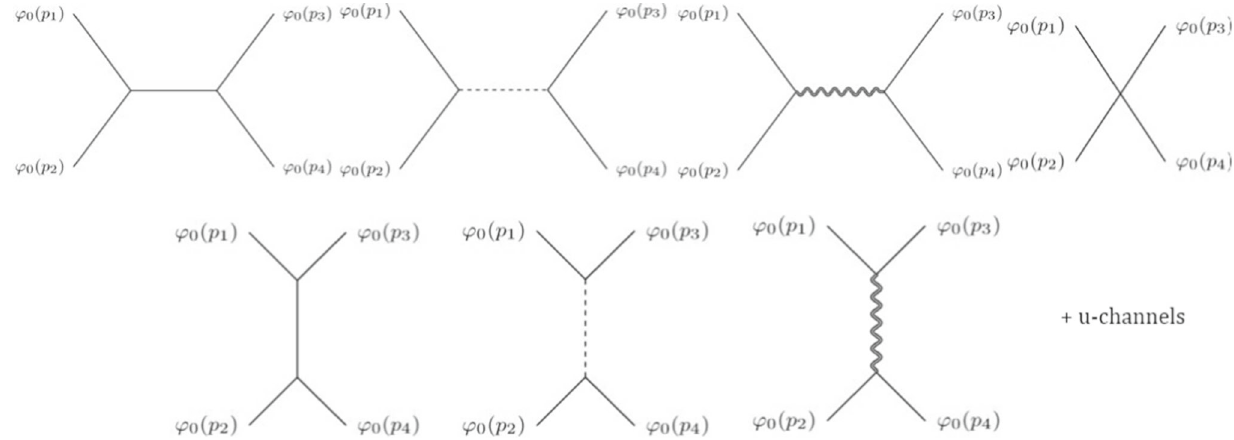
Fig. 6 Feynman diagrams for the ϕ 0 ϕ 0 → ϕ 0 ϕ 0 scattering when a potential for the higher dimensional scalar, “parent” of ϕ 0 , has been turned o.n